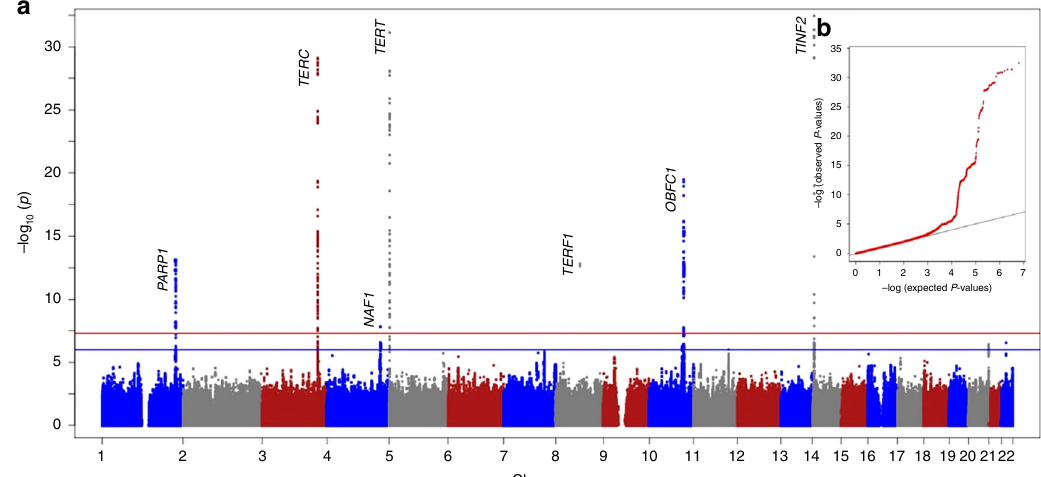
Fig. 1 LTL associations in the SCHS discovery GWAS. a Seven hits at chromosome 1, 3, 4, 5, 8, 10, and 14 were identi fi ed beyond the genome-wide signi fi cance threshold (score test P < 5 × 10 − 8 , red line) and 4 hits at chromosome 7, 11, 20, and 22 were identi fi ed beyond the suggestive signi fi cance threshold (score test P < 1 × 10 − 6 , blue line). b QQ-plot of observed compared to expected P -values in the SCHS discovery GWAS indicated minimal in fl ation of study results ( λ = 1.043)